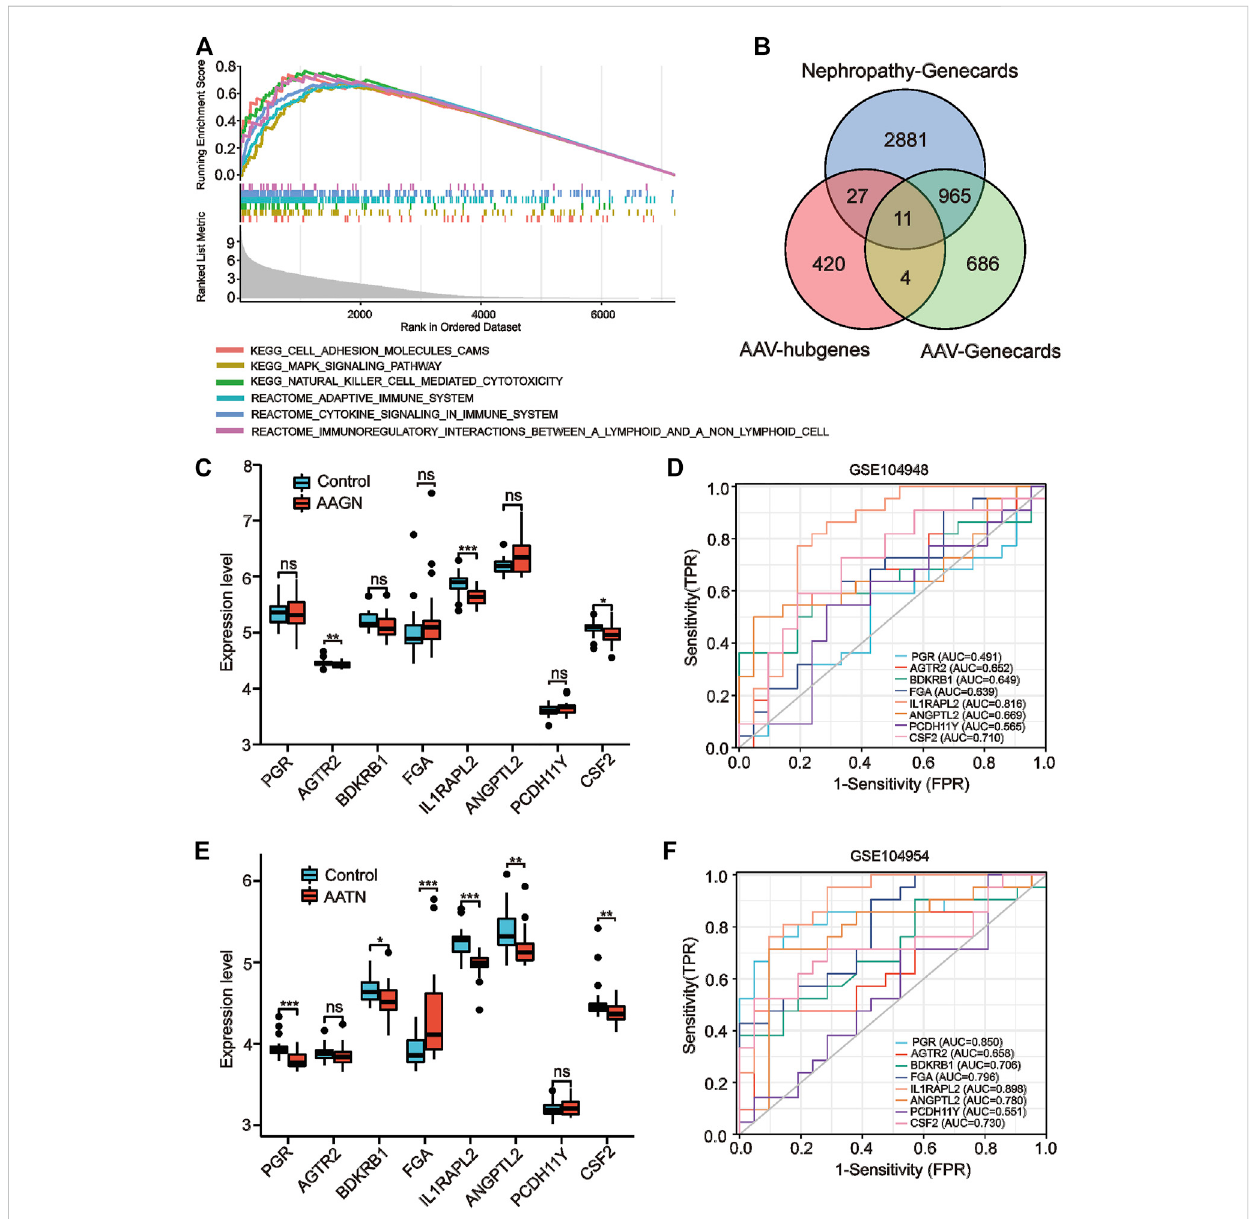
FIGURE 3 Gene set enrichment analysis (GSEA) enrichment analysis and validation of co – key genes in independent datasets. (A) GSEA enrichment results. (B) Venn diagram screening for co-key genes. (C, E) Expression of co-key genes in the GSE104948 and GSE104954 datasets for kidney injury in